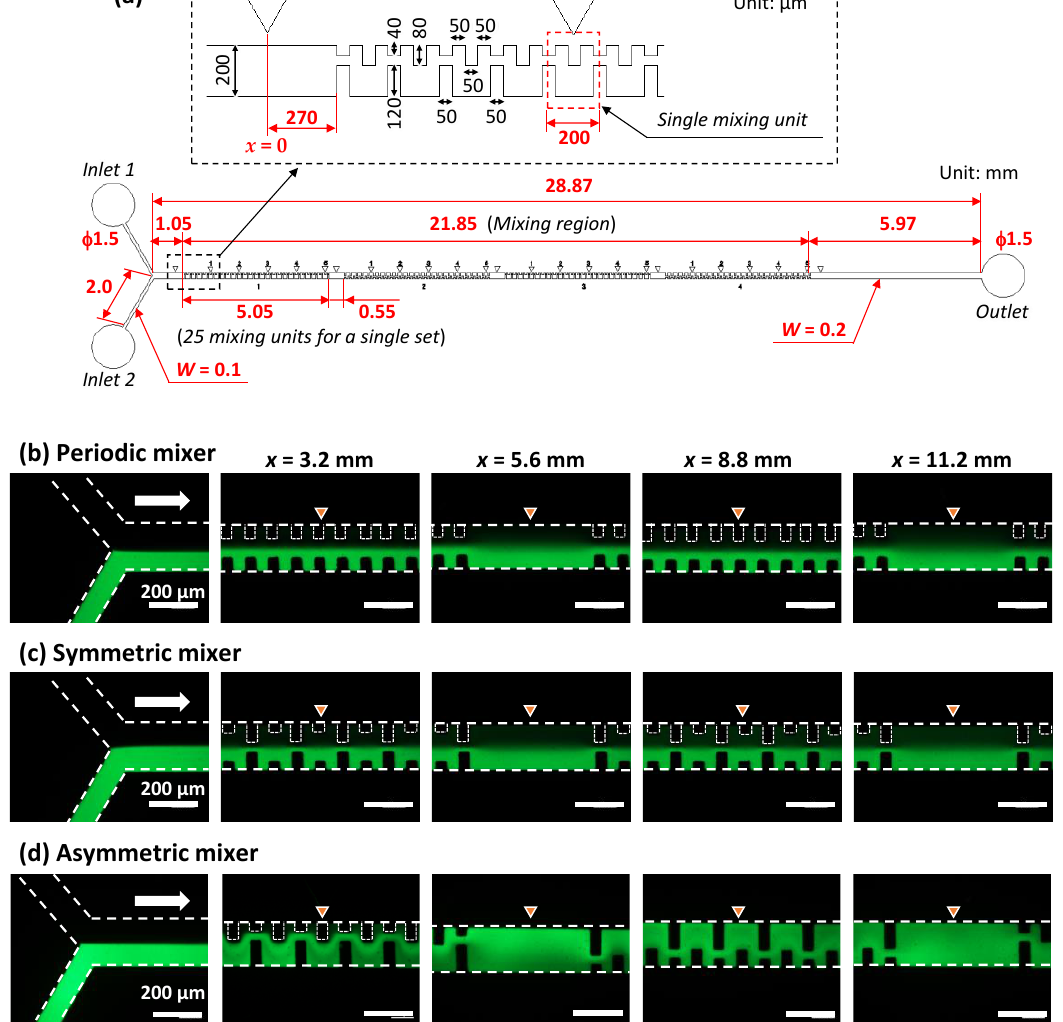
Figure 2. Experimental investigation of mixing behaviors. ( a ) Detailed design of the asymmetric mixer employed in the experiments. Experimental results showing fluorescence microscopy images of the mixing process in the ( b ) periodic mixer, ( c ) symmetric mixer, and ( d ) asymmetric mixer. Pure water and fluorescein-dyed water (0.1 mol/m 3 ) were introduced at the same flow rate of 5 µL/min (a total flow rate of 10 µL/min and Re = 1.3).